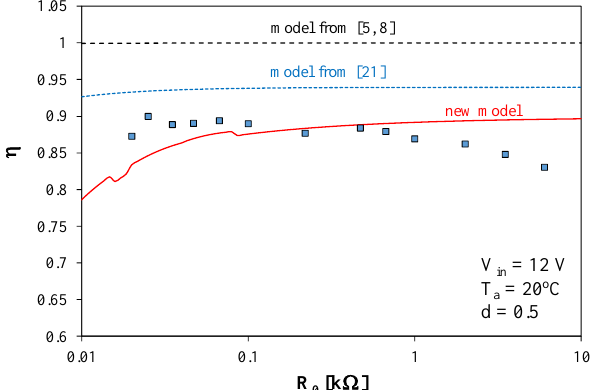
Figure 9. Computed and measured dependences of watt-hour efficiency of the boost converter on load resistance.